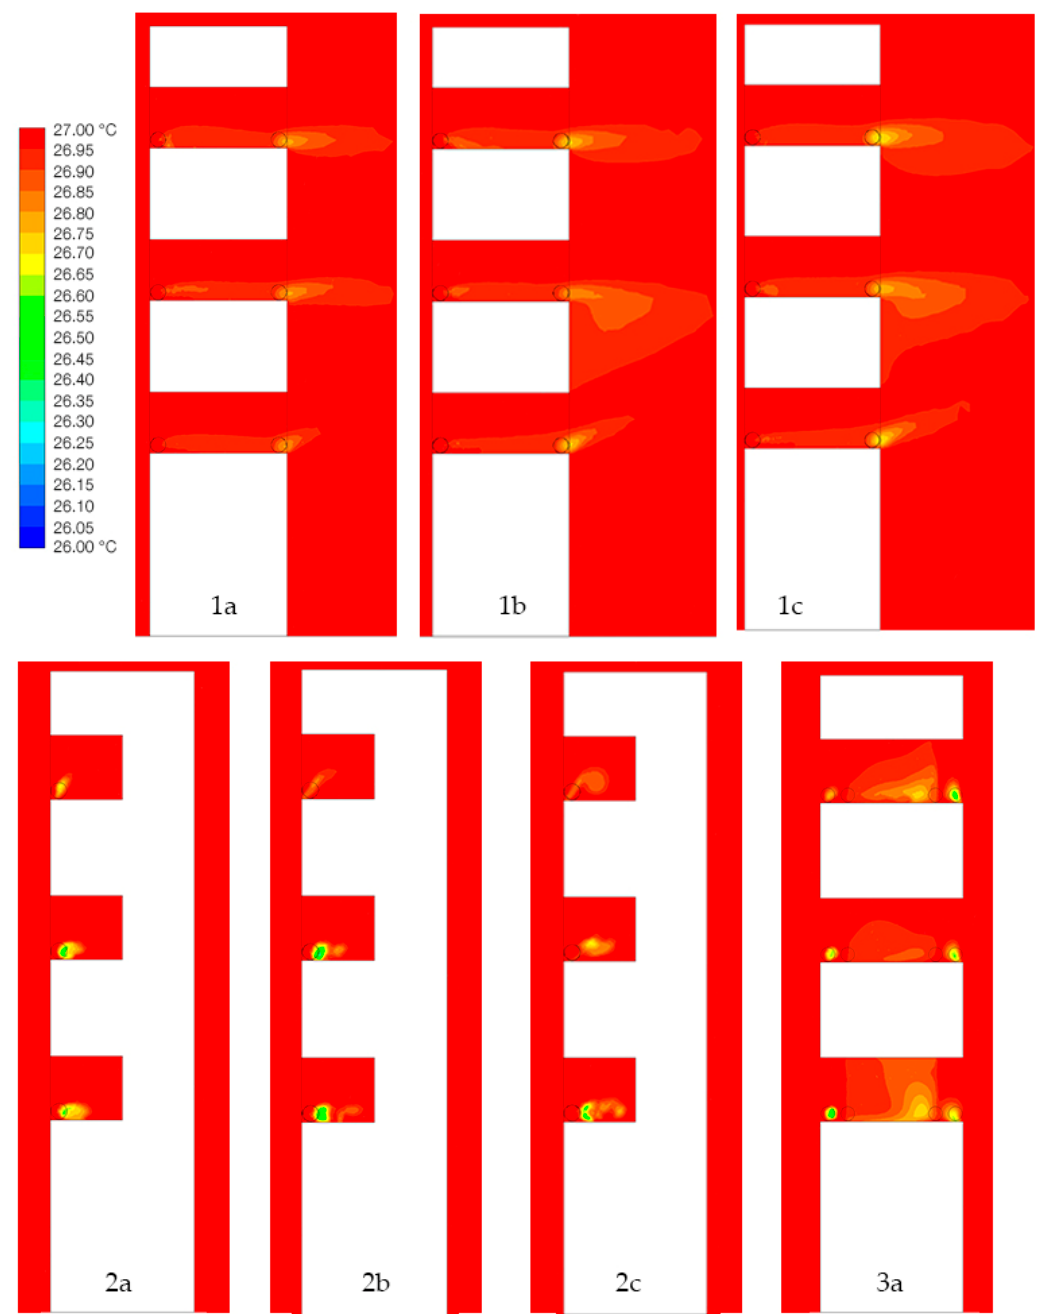
Figure 16. Temperature contour along a vertical plane through the centre of sky garden; (1a) Central sky garden b/B = 0.4, (1b) Central sky garden b/B = 0.6, (1c) Central sky garden b/B = 0.8, (2a) Corner sky garden b/B = 0.4, (2b) Corner sky garden b/B = 0.6, (2c) Corner sky garden b/B = 0.8, (3a) Periphery sky garden a/A = 0.5.